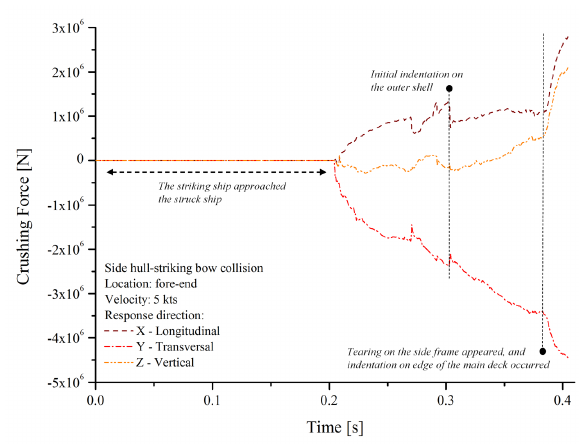
Figure 11: Structural responses of the struck ship – fore-end against collision with velocity 5 kts.